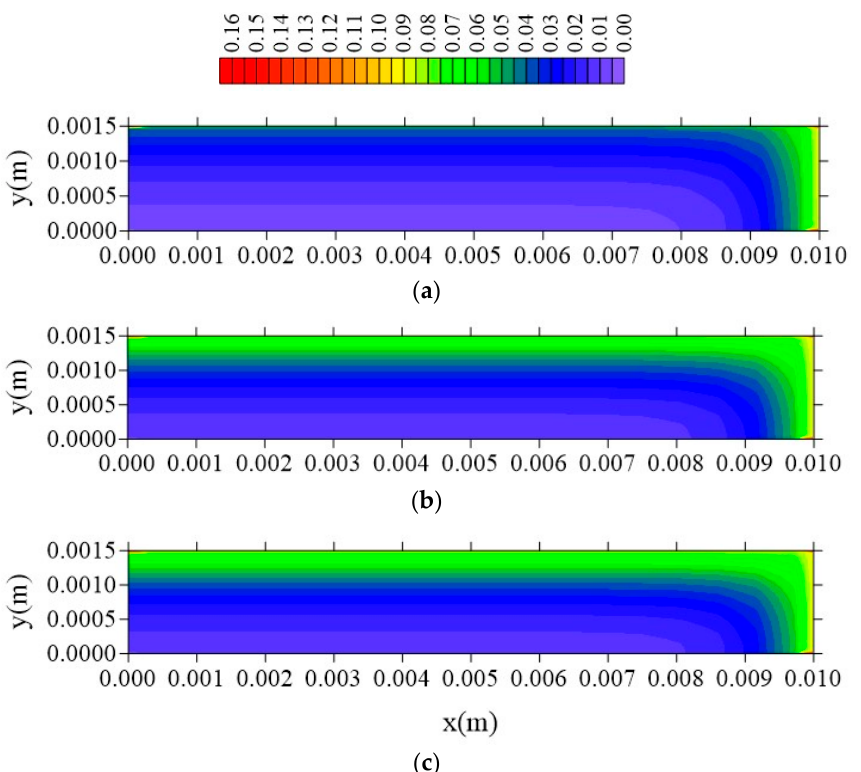
Figure 27. Distribution of entrapped solute concentration (S in kg/kg) in plan x = R x /2 for different distances l y (t = 211 h, Cases 9, 11, and 12). In which ( a ) l y = 0.001 m; l x = 0.1 m and l z = 0.1 m ; ( b ) l y = 0.01 m; l x = 0.1 m and l z = 0.1 m ; ( c ) l y = 0.1 m; l x = 0.1 m and l z = 0.1 m .